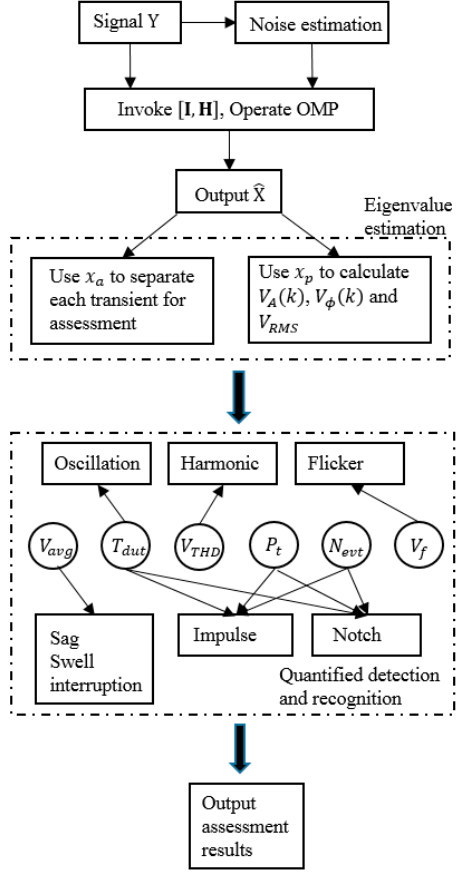
Figure 2. The structure of joint-domain dictionary mapping (JDM) for dealing with multiple power disturbances (MPDs).